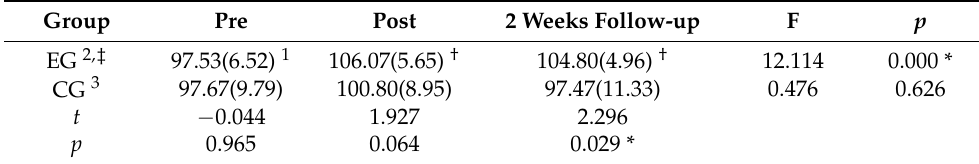
Table 6. Changes in cadence by the